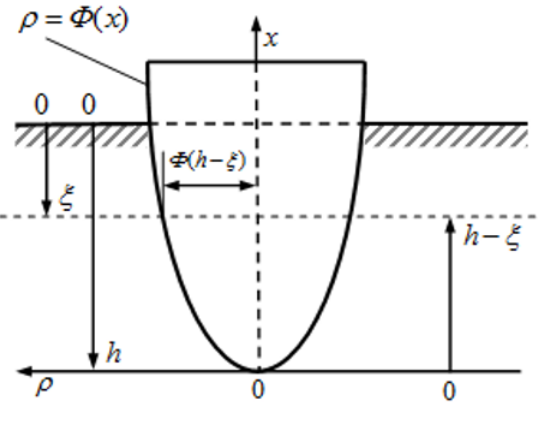
Figure 1. The cylindrical cavity expansion